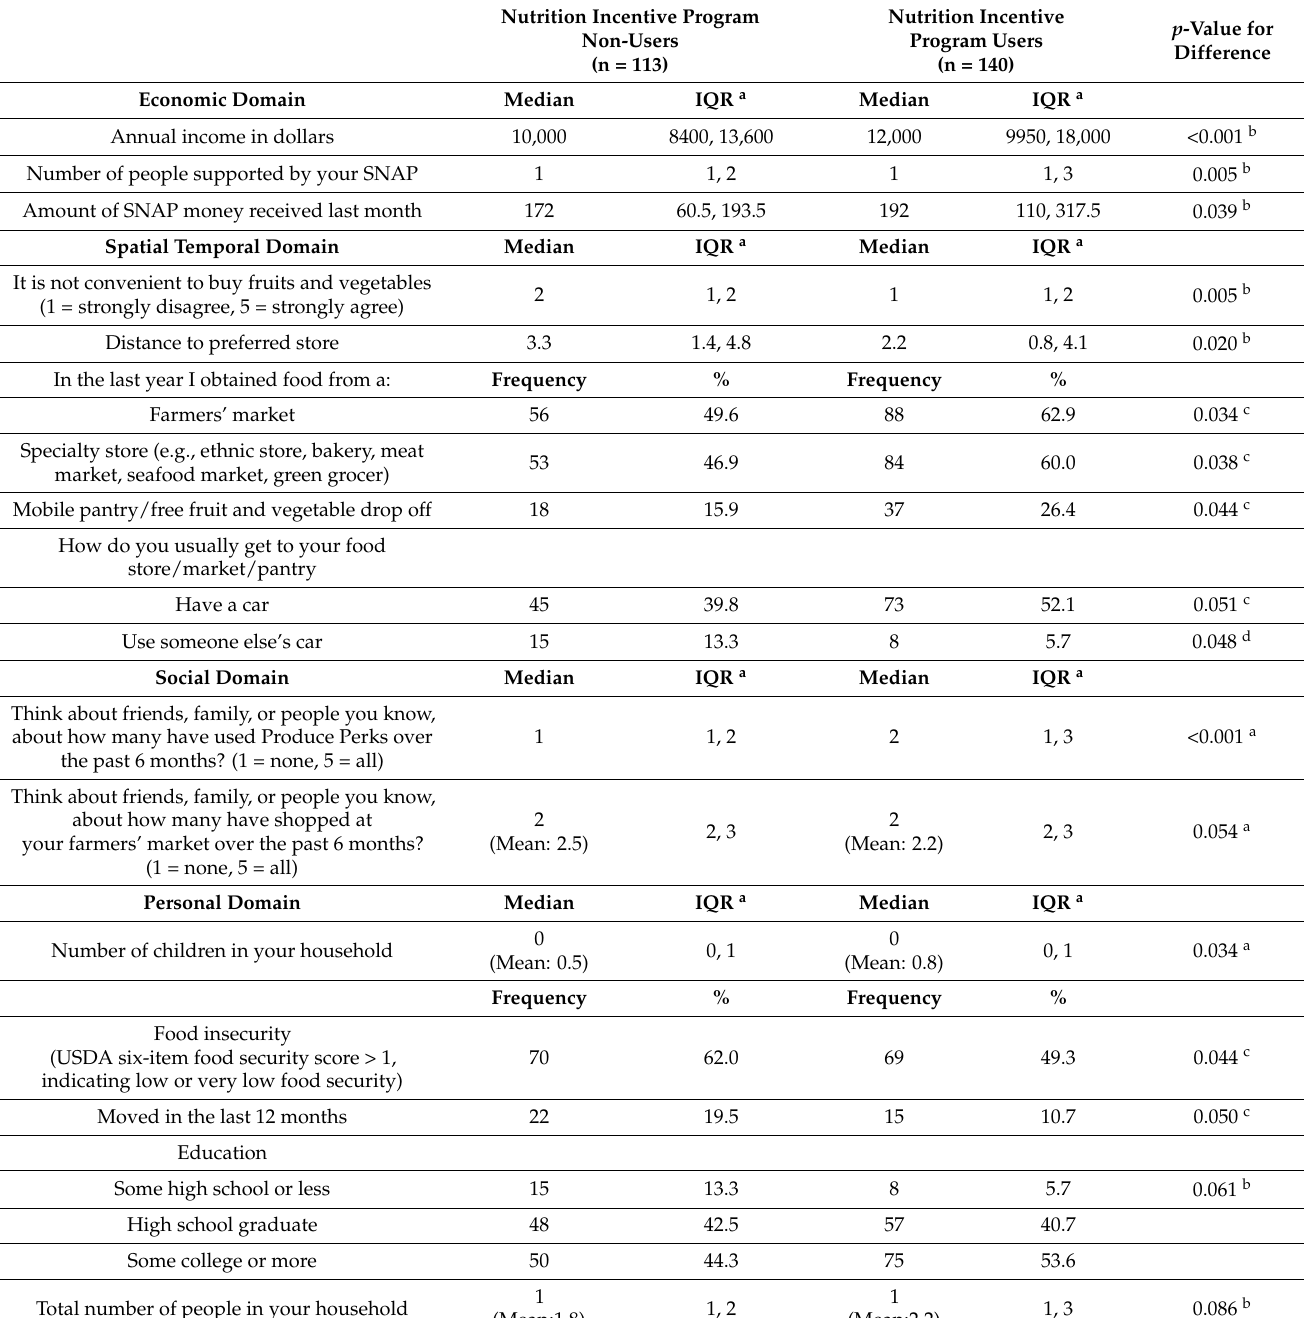
Nutrition Incentive Program